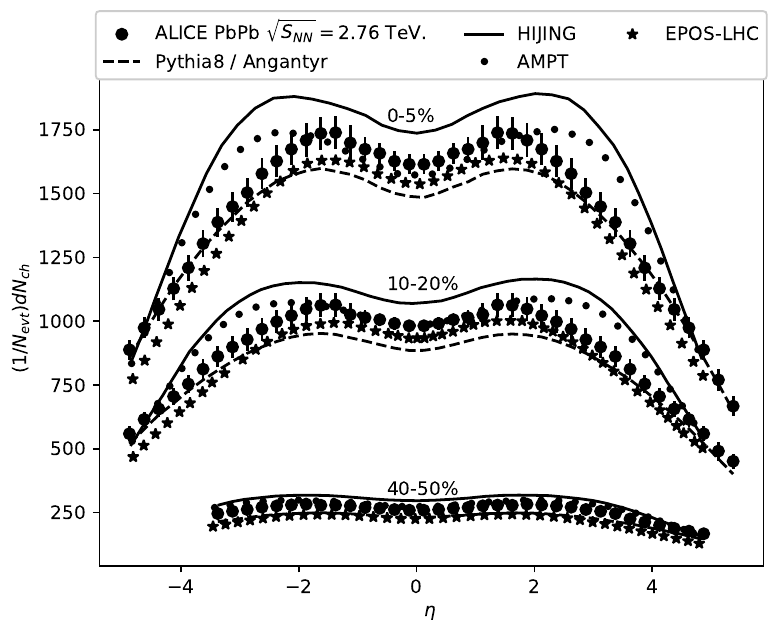
Figure 26 . Comparison of Angantyr to the generators EPOS-LHC, AMPT and HIJING. The (cid:12)gure shows charged particle production as function of pseudo-rapidity in PbPb at p s measured by ALICE